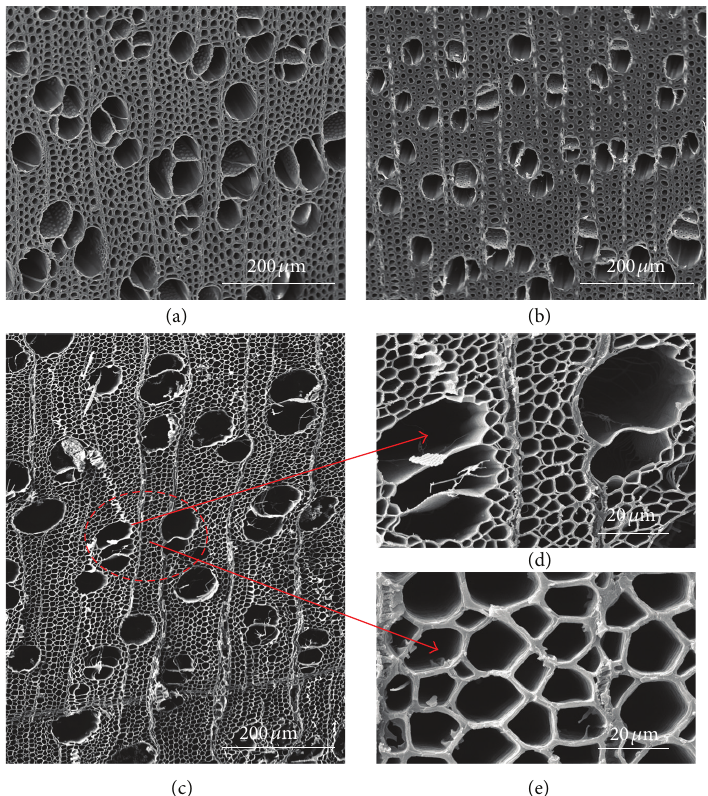
Figure 2: SEM images of the cross-section of (a) the original wood, (b) the wood coated by TiO 2 sol, (c) wood-templated TiO 2 , (d) the magnified calcined wood vessels, and (e) the magnified calcined wood fibers,